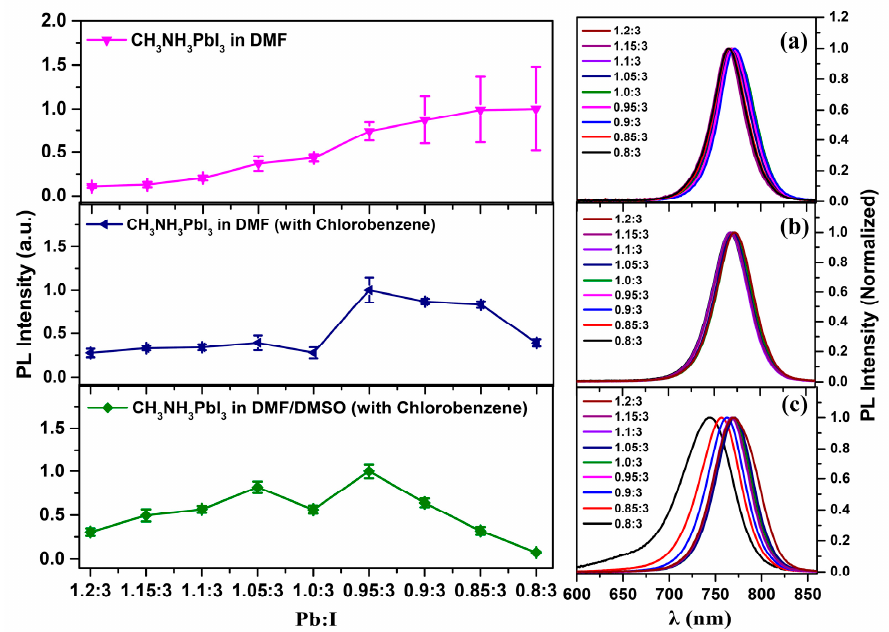
Figure 2. The PL Intensity and spectra of CH 3 NH 3 PbI 3 films composed of different precursor ratios, via different fabrication methods. ( a ) Precursors dissolved in DMF and spun without any solvent dropping. The excitation was at 450 nm and with a power of 5 W/cm 2 . ( b ) Precursors dissolved in DMF and spun with chlorobenzene dropping. The excitation was at 532 nm, with a power of 4.7 W/cm 2 . ( c ) Precursors dissolved in DMF/DMSO and spun with chlorobenzene dropping. The excitation was at 532 nm, and with a power of 5.5 W/cm 2 .